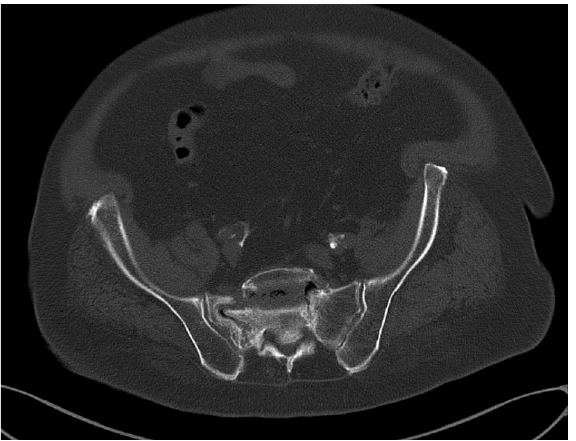
Figure 1. Bilateral fracture of the sacrum with moderate displacement on the right and slight displacement on the left